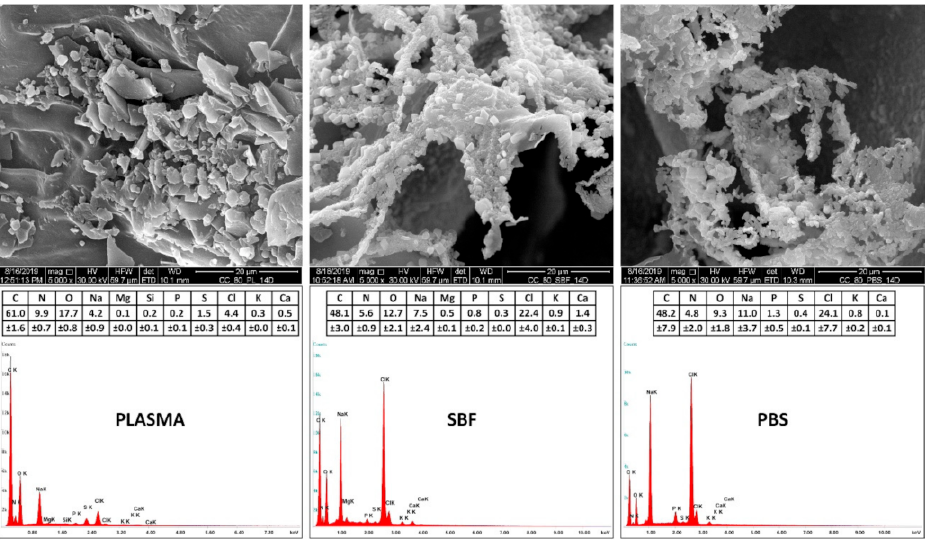
Figure 3. Representative SEM images (mag. 5000 × ) of the inner structure of collagen scaffolds exposed for 14 days in human blood plasma, SBF, and PBS. The detailed images reveal the adsorption of various components of the blood plasma and salt precipitates after exposure in selected media. The adsorption of the blood plasma components and salts is illustrated by the qualitative EDS analysis (mean and standard deviation, n = 5), namely by qualitative increases in weight fraction (wt%) of the Mg, Si, P, Cl, K, and Ca elements. The inner structure of collagen scaffolds prior to experimentation (data not shown) contained only C (62.9 wt%), N (13.7 wt%), O (20.8 wt%), Na (0.5 wt%), S (0.7 wt%) and Cl (1.4 wt%)